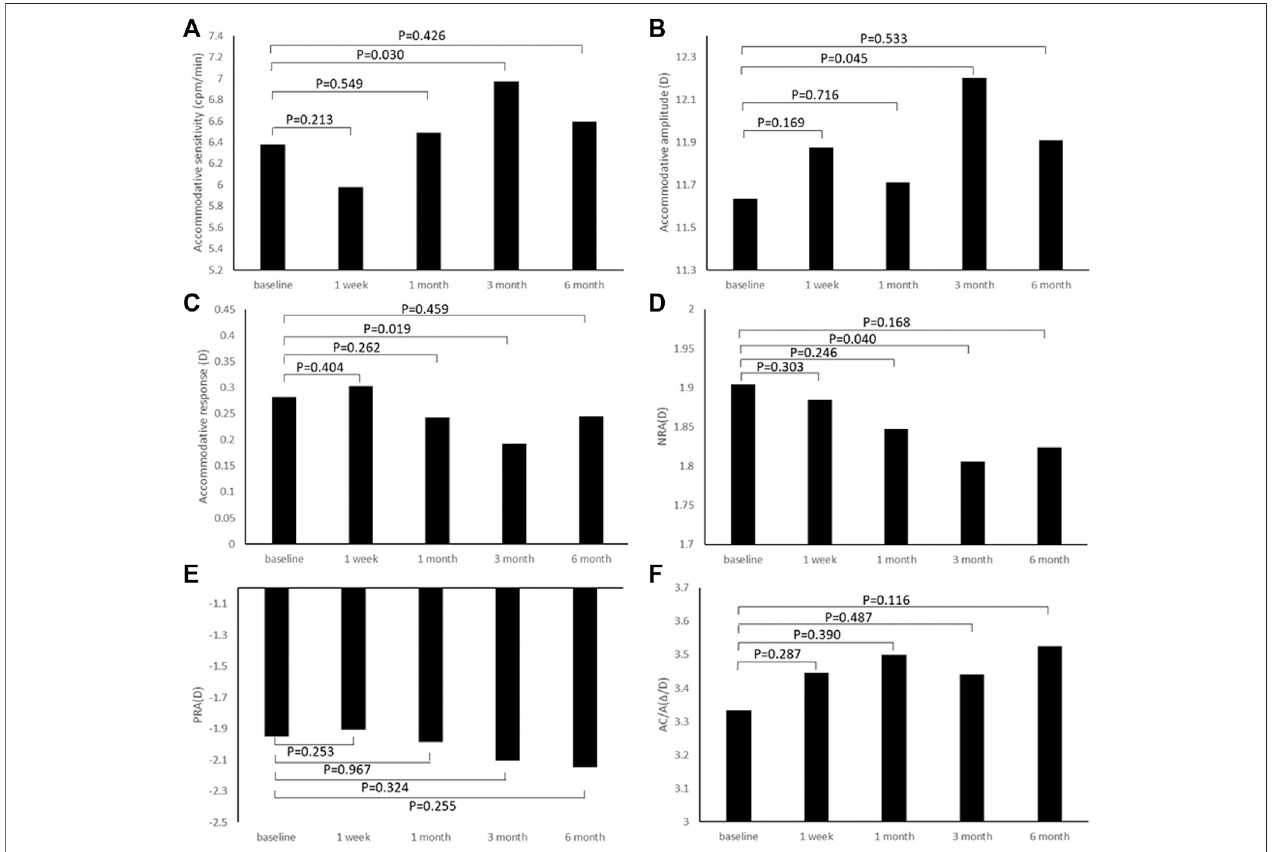
FIGURE 2 | Change in accommodative system parameters after the instillation of 0.01% atropine eye drops. (A) Accommodative sensitivity. (B) Accommodative amplitude. (C) Accommodative response. (D) NRA, negative relative accommodation. (E) PRA, positive relative accommodation. (F) AC/A, accommodative convergence/accommodation